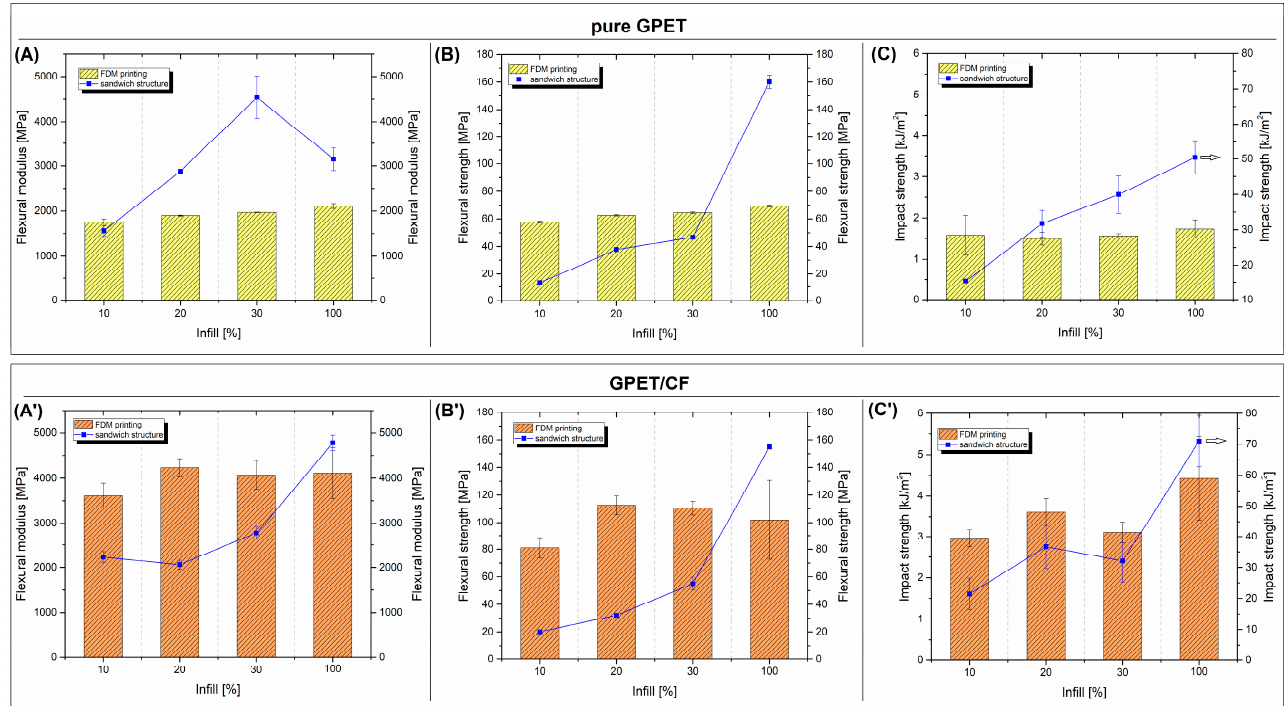
Figure 5. Mechanical properties of FDM-printed samples and compression molded sandwich struc- tures: ( A,A’ ) flexural modulus, ( B,B’ ) flexural strength, and ( C,C’ ) Charpy impact strength. The top plots present the results for pure GPET samples, while the bottom plots are for GPET/CF materials. According to the obtained results, the mechanical properties of the pure GPET printed samples are only slightly influenced by the infill’s density. The influence of the infill density is mainly negligible. The increase between the 10% and 100% infill samples for the flexural modulus and strength was only around 15%, and for impact strengths, the increase was approximately 10%. Visible improvements in mechanical properties were observed for samples with CF reinforcements; however, the changes between the samples with different infill densities are again insignificant.